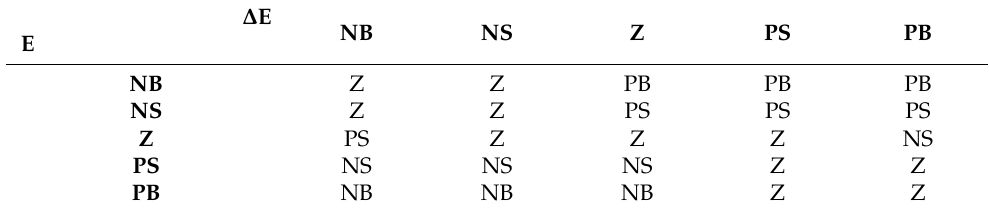
Table 4. Base of the fuzzy controller rules used for FL-INC.